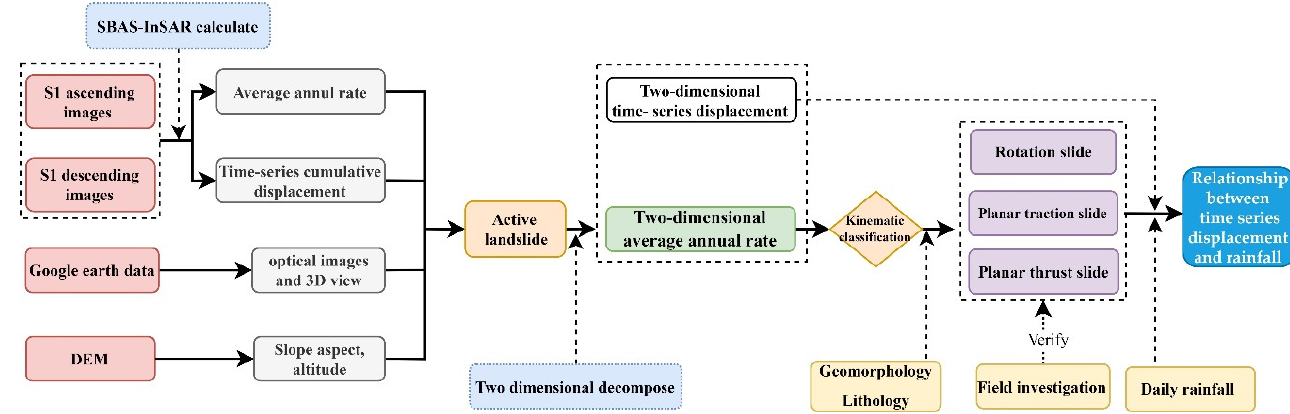
Figure 3. Research flow